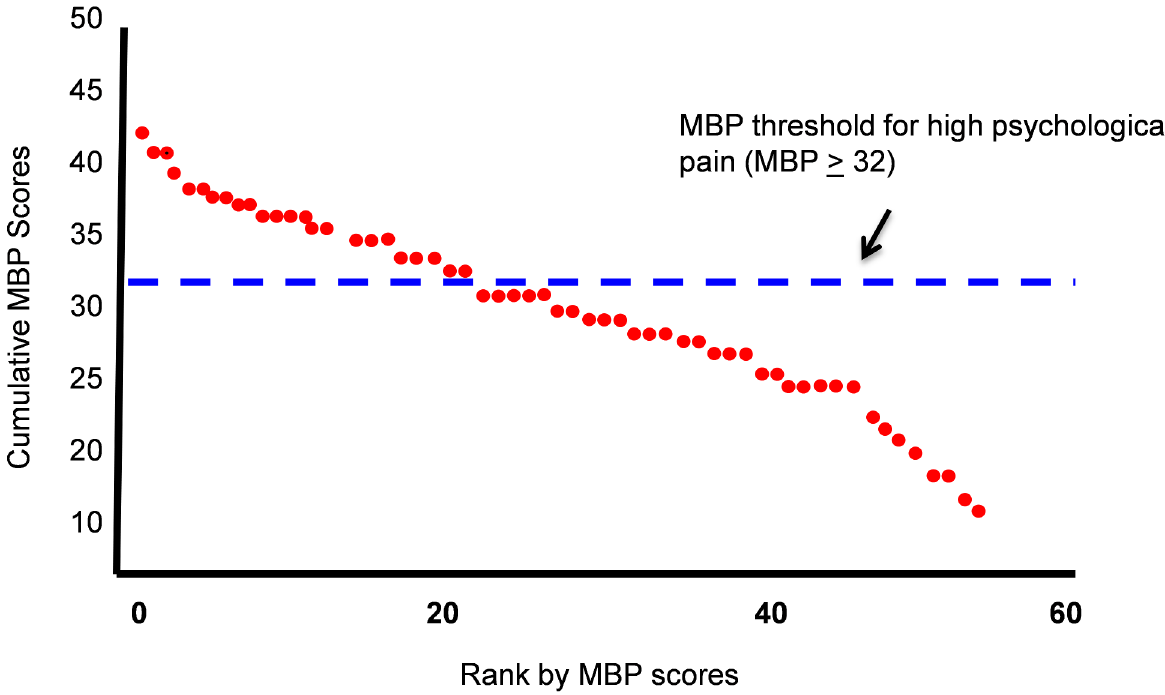
Fig 1. Cumulative distribution graph of MBP scores for suicidal patients (N = 57). Suicidalpatients were rankedaccordingto MBP scores from highestto lowest.